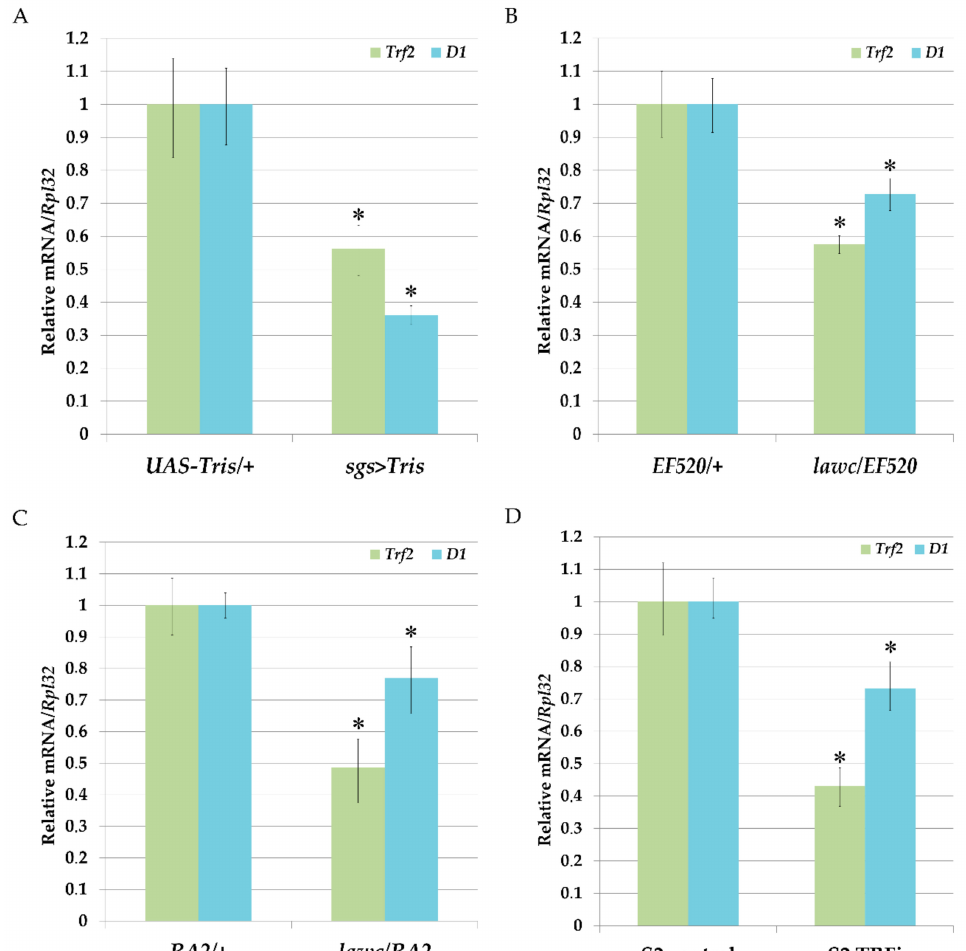
Figure 5. Analysis of Trf2 and D1 genes mRNA levels in salivary glands of the third instar larvae, adult flies and S2 cells. The relative expression levels of Trf2 and D1 genes were examined using qRT-PCR as described in materials and methods. ( A ) Expression levels of Trf2 and D1 genes detected in salivary glands of: control UAS-Tris /+ larvae and after Trf2 knock-down by ddRNAi ( sgs > Tris ). ( B ) Expression levels of Trf2 and D1 genes in lawc p1 / EF520 adult flies compared to control EF520 /+ flies. ( C ) Expression levels of Trf2 and D1 genes in lawc p1 / Df(1)RA2 adult flies compared to control Df(1)RA2 /+ flies; ( D ) expression levels of Trf2 and D1 genes in the S2 cells after RNAi-mediated silencing of Trf2 (S2-TRFi) compared to control (S2 cells treated with dsRNA corresponding to eGFP gene). Data are presented as the mean ± SD of three independent experiments. * p < 0.05, compared to